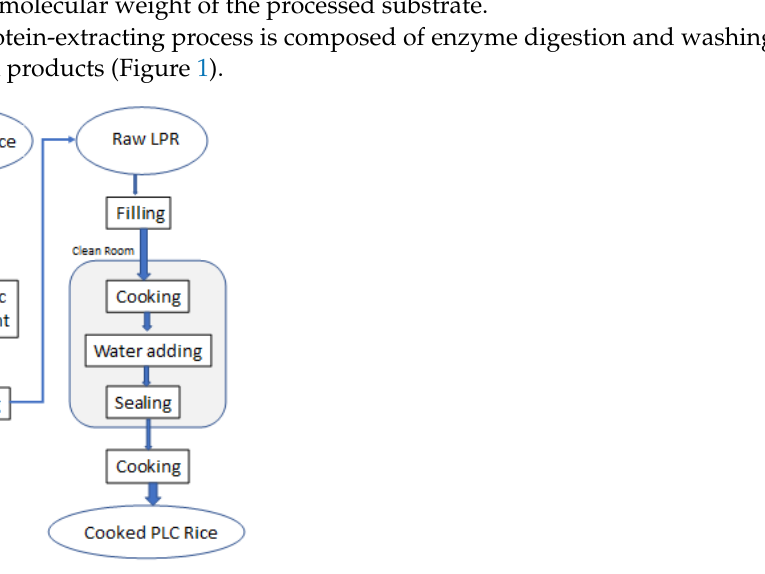
Figure 1. Production flow chart of low-protein white rice. Two-step treatments are necessary: mixing the enzyme solution and cooking and sealing. In the first step, surface bran residues and germs are washed away with water. The washed white rice is placed in a reaction solution containing dissolved enzyme mix and citric acid and allowed to soak for a certain period (up to 24 h) at a temperature > 50 ◦ C and pH < 3.0 conducive to enzyme